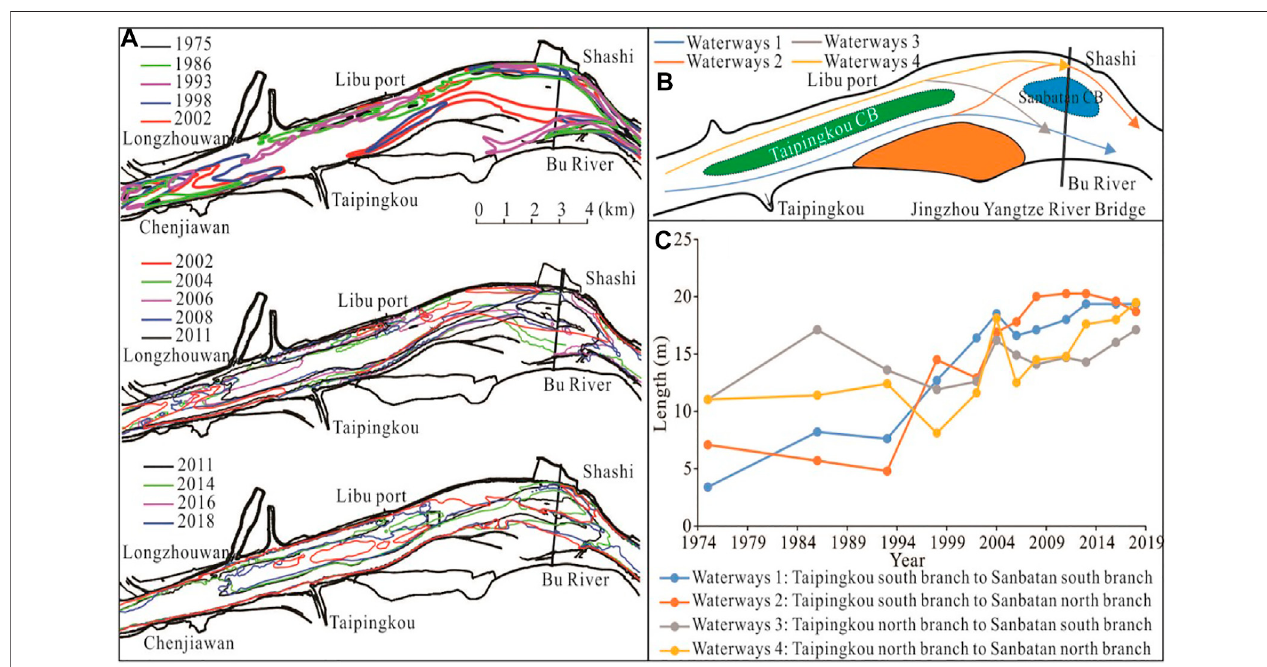
FIGURE 12 | Waterway condition of the Taipingkou reach; (A) 4.5 m contour; (B) Route of waterway; (C) Length of 4.5 m isobath.